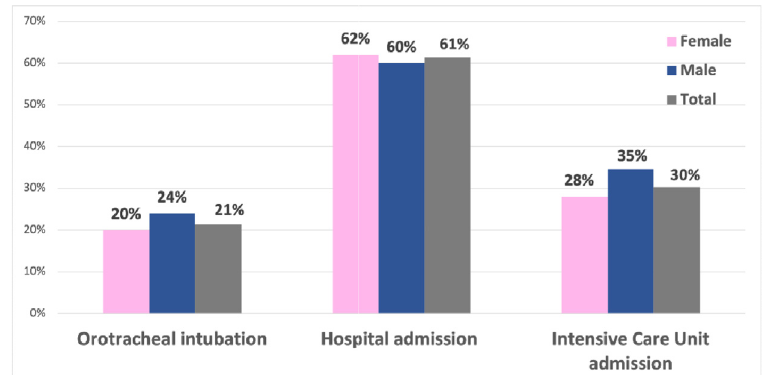
Fig. 2. Severity of hereditary angioedema attacks.